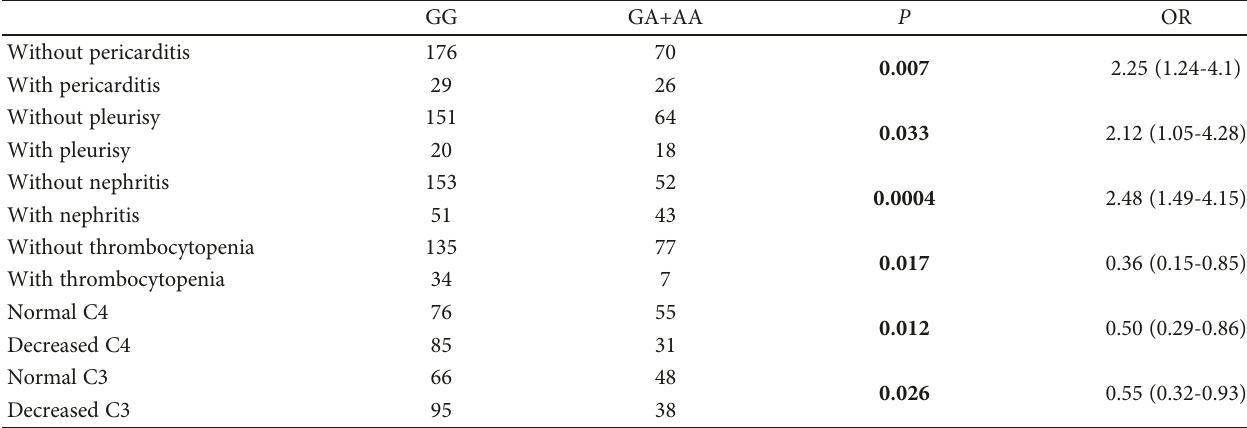
Table 3: Association between SLE phenotypes and rs6920220